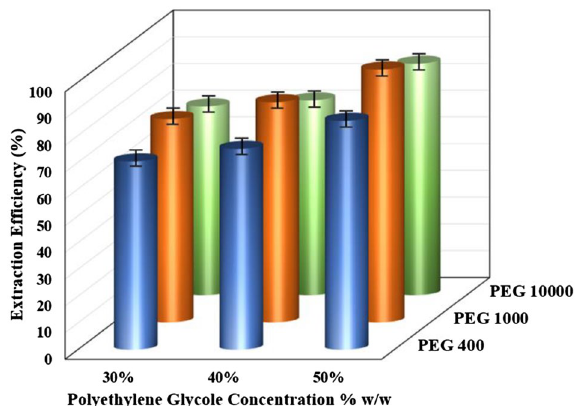
Figure 2. Effect of amount of PEG on the extraction of Co(II) (T = 25 °C, Time = 30 min, Co(II) = 500 ppm, (NH